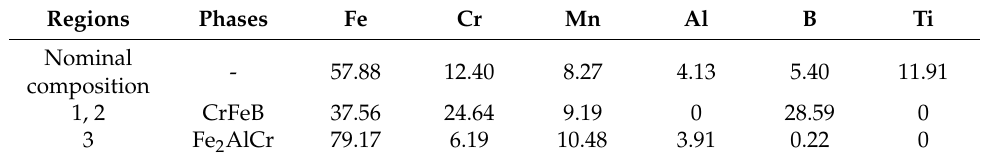
Table 1. Average composition of the phases in 25 vol.%TiB 2 /Fe-15Cr-10Mn-5Al composite (wt.%).